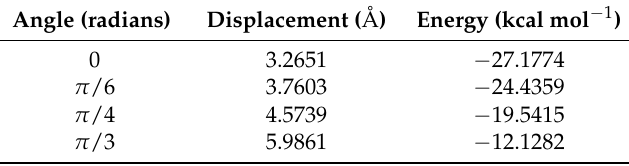
Table 2. Minimum displacements and corresponding interaction energies for fixed tilt